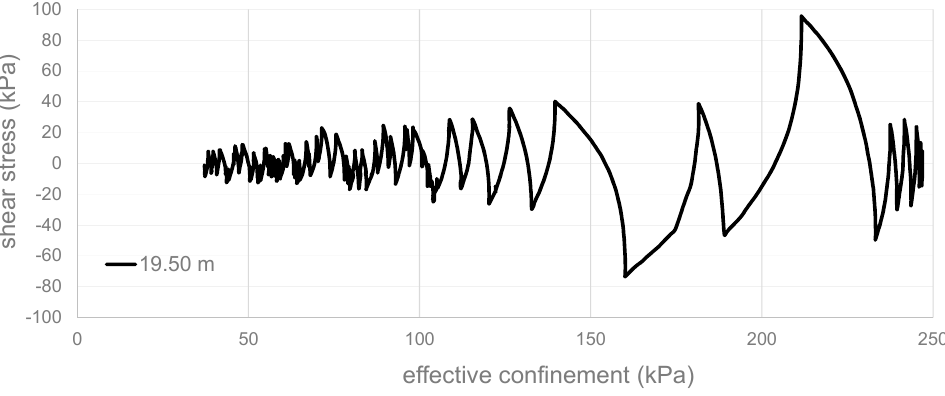
ff ective confinement vs. shear stress at 19.50 m Figure 12. Model-10 m: Effective confinement vs. shear stress at 19.50 m depth. Figure 12. Model-10 m: E Figure 12. Model-10 m: Effective confinement vs. shear stress at 19.50 m depth. Figure 12. Model-10 m: Effective confinement vs. shear stress at 19.50 m depth.